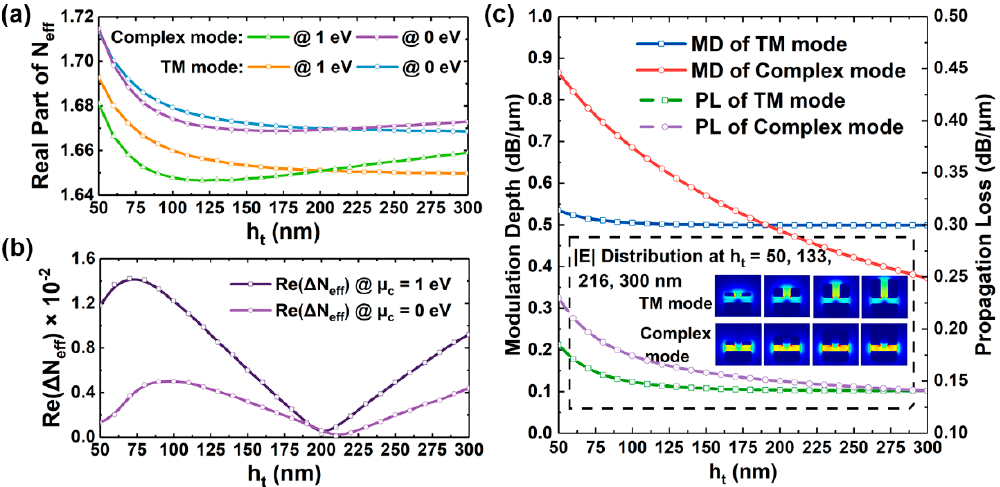
Figure 8. Re( N eff ), Re( Δ N eff ), MD as well as PL of the TM mode and complex mode in the DBOSW modulator versus h t are shown in ( a ), ( b ) and ( c ), respectively. The illustration in ( c ) shows the variation of electric field distribution for the TM mode and complex mode versus h t .